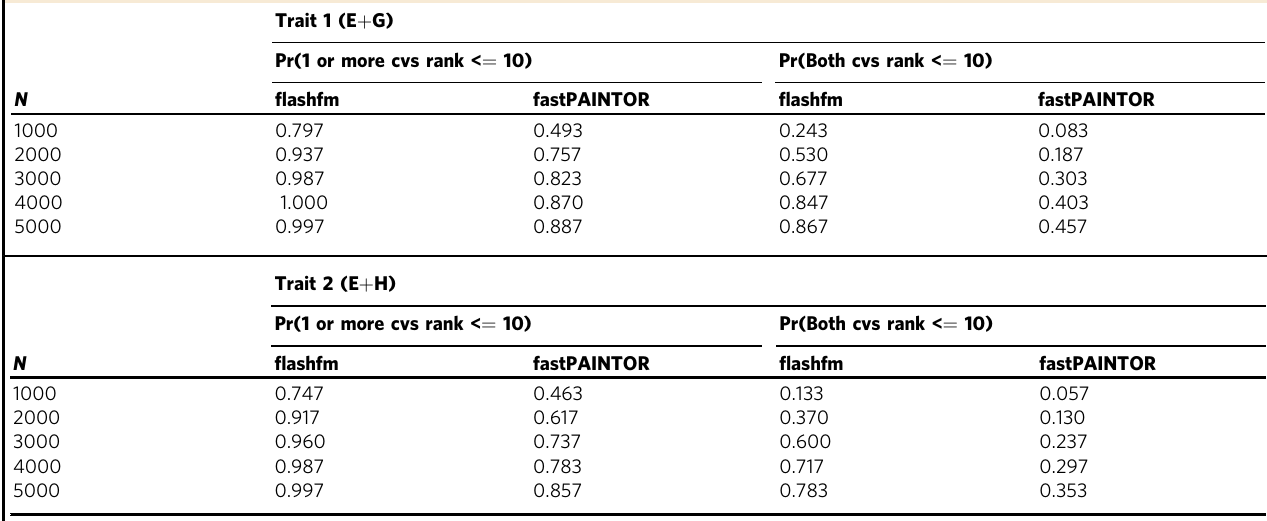
Table 5 Comparison of probabilities that causal variants (cvs) have rank 10 or less, from fl ashfm and fastPAINTOR, varying sample